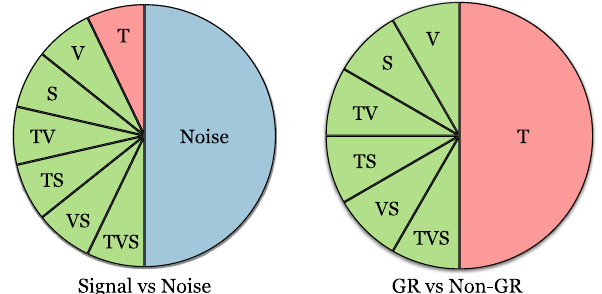
FIG. 17. Illustration of the prior odds assigned to models and subhypotheses in the hierarchical Bayesian search for generically polarized stochastic backgrounds. When constructing O SIG assign equal prior probability to the noise and signal models, as well as equal probability to the seven signal subhypotheses f T ; … ; TVS g . Similarly, when constructing O NGR probability to the non-GR and GR models and identically weight the six non-GR subhypotheses f V ; … ; TVS g